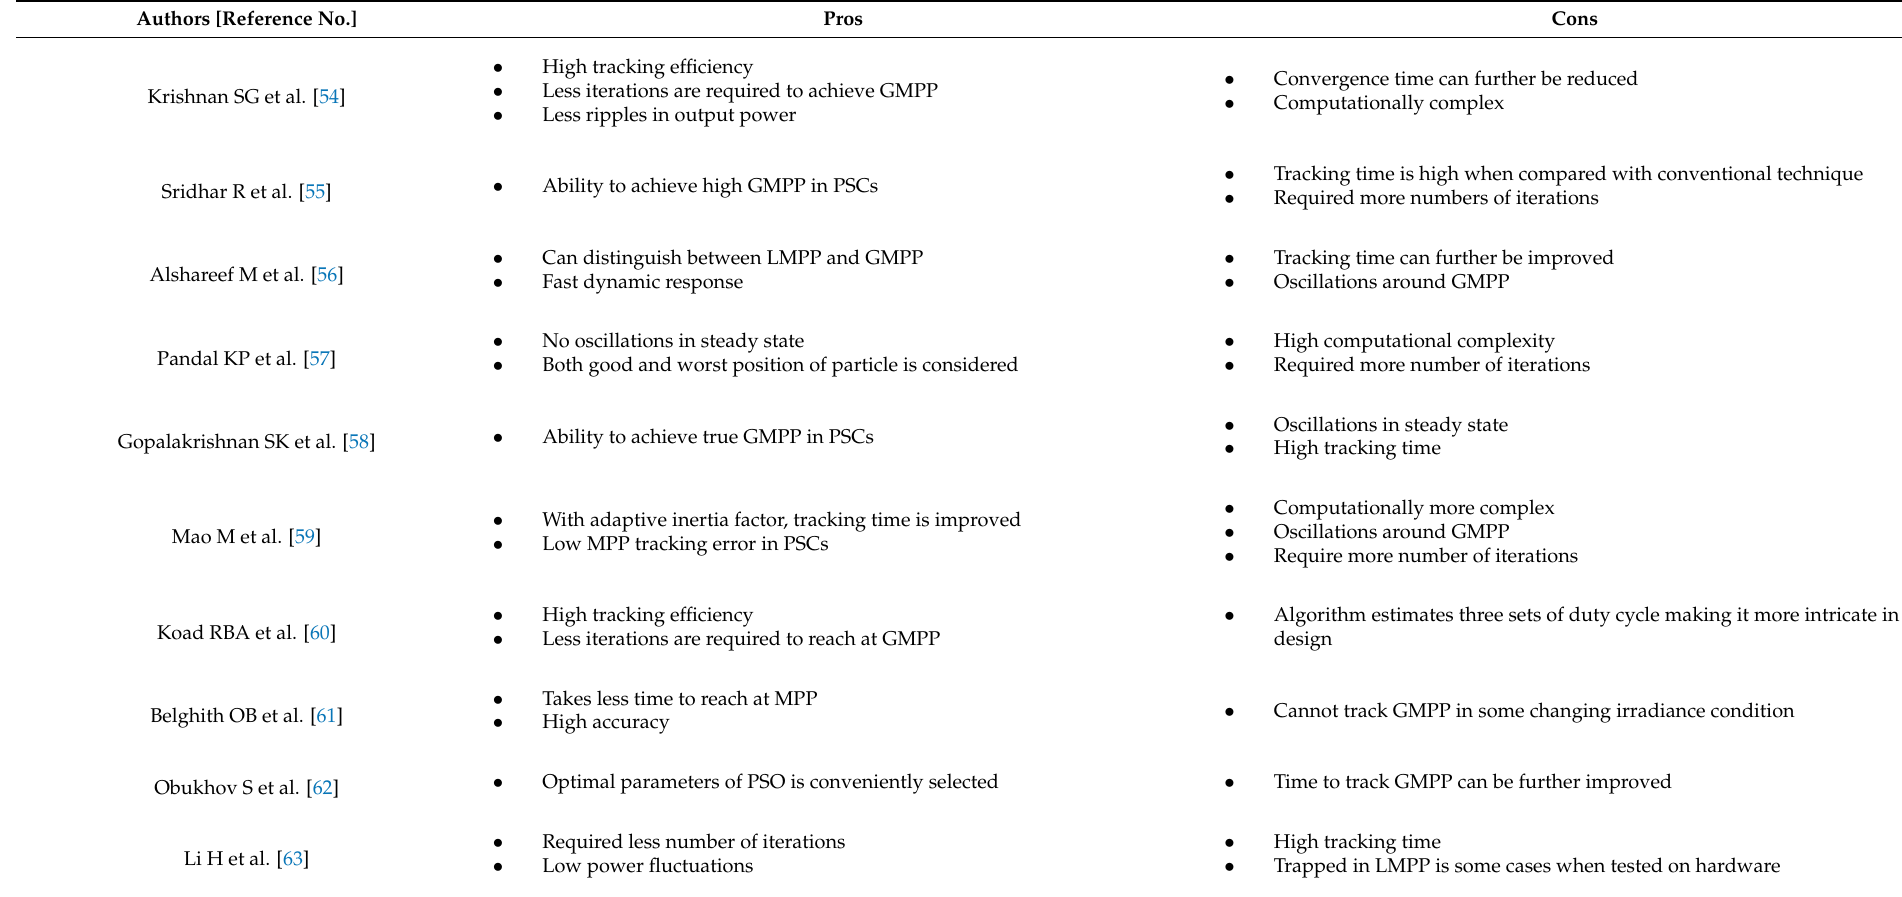
Table 4. Pros and cons of recent work based on swarm intelligence